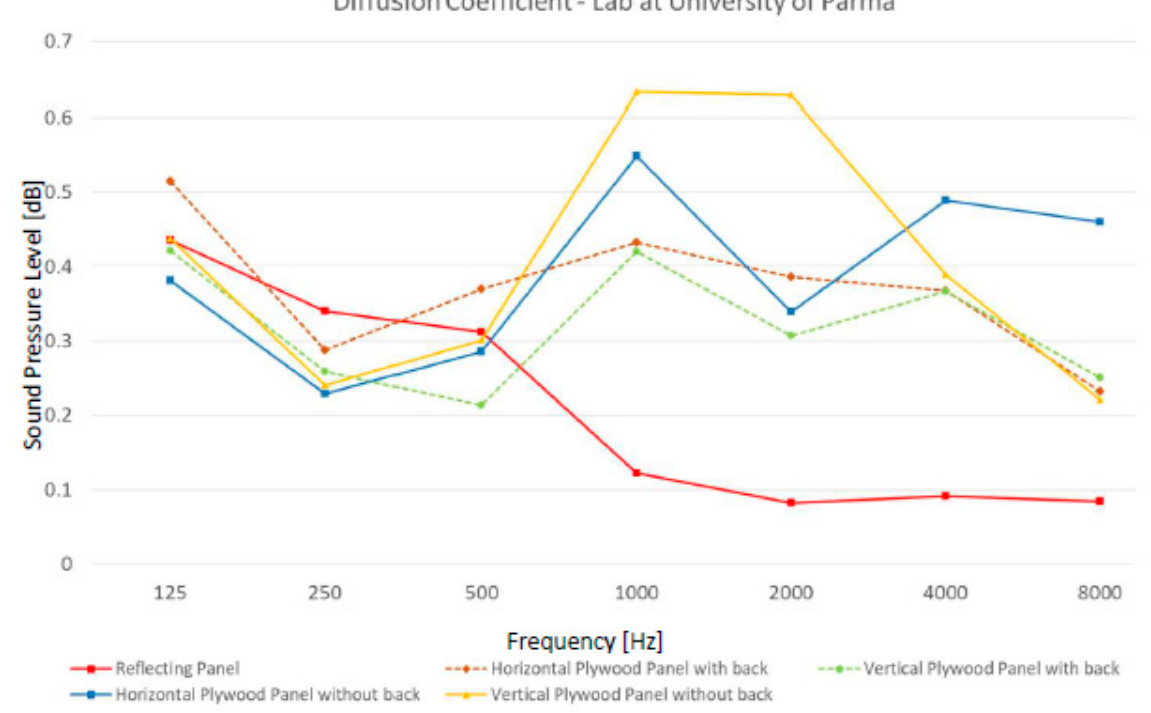
Figure 12. Directional diffusion coefficient related to the samples tested inside Room B. Among all the test samples and relative configurations tested in Room B, the specimen indicating the best performance of the diffusion coefficient is the plywood QRD in the vertical configuration, without any reflecting panel behind. In particular, the results indicate that the performance of (cid:1856) = 0.63 has been achieved at 1 and 2 kHz. The worst performance is given at 250 Hz and 8 kHz, with values of (cid:1856) floating between 0.23 and 0.22, respectively.